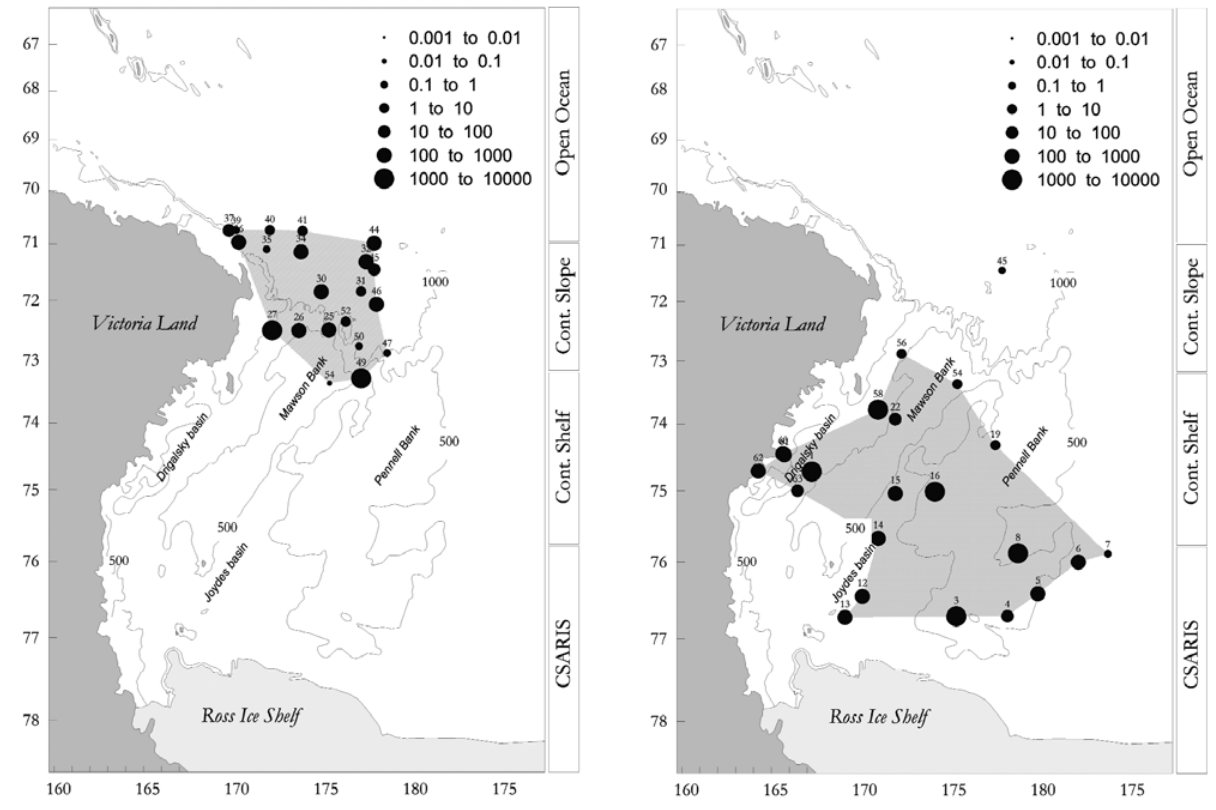
F IG . 2. – Horizontal distribution of krill abundance ( E.superba and E.crystallorophias ). Values are standardised at a individuals of krill caught per 1000 m 3 of